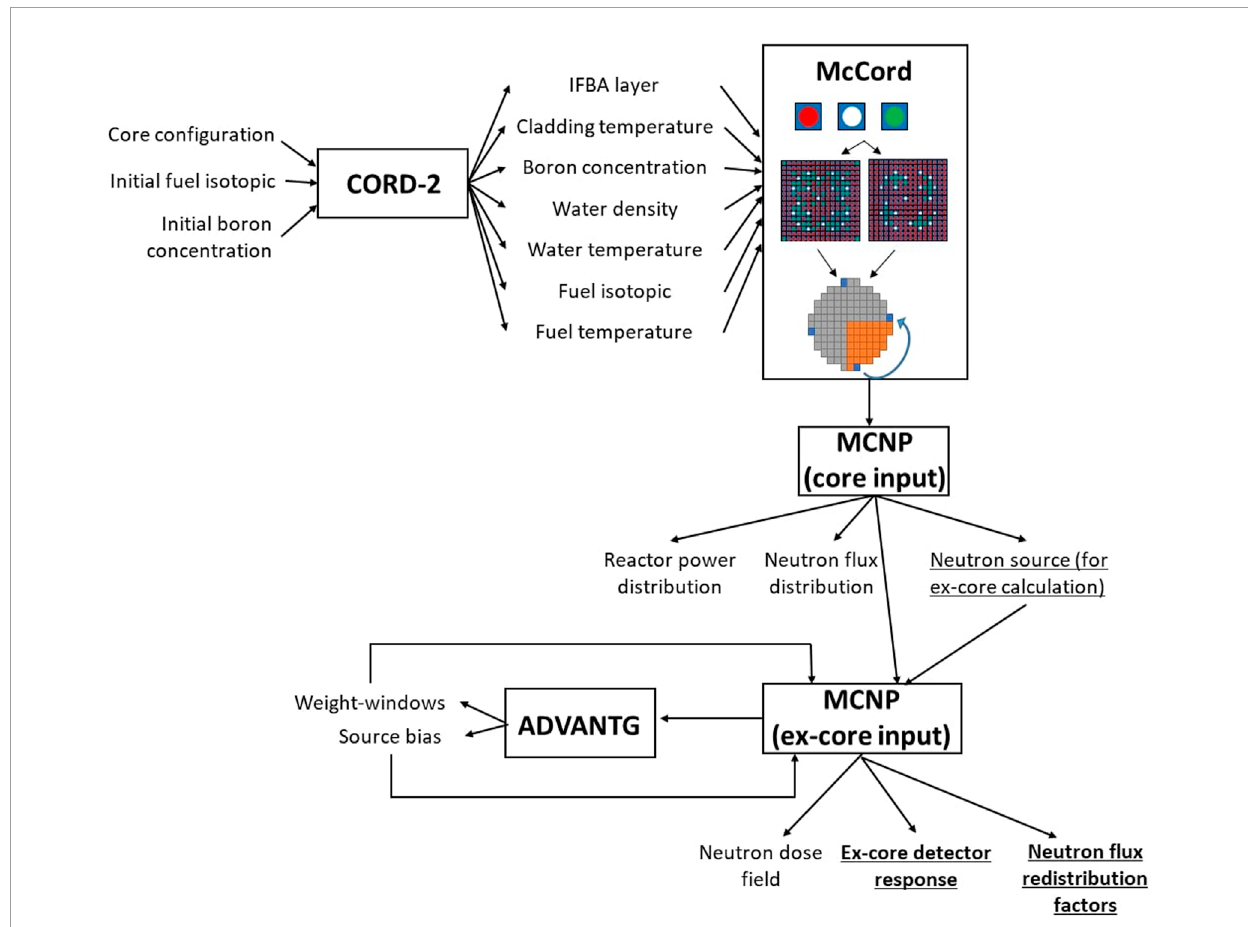
FIGURE 3 Calculation procedure scheme to obtain ex-core detector